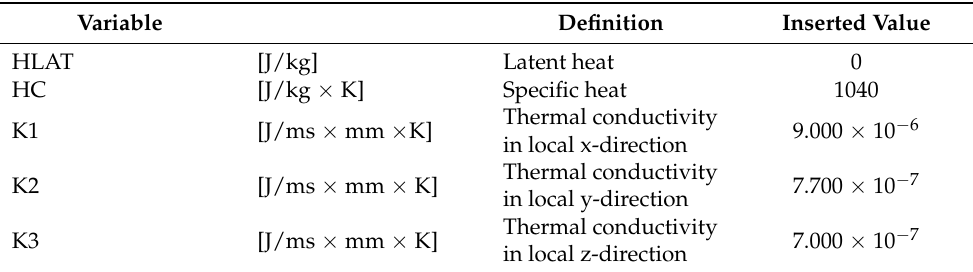
Table 6. T02 material parameters for the thermal orthotropic characteristic of T800/F3900, as pub- lished in [33].